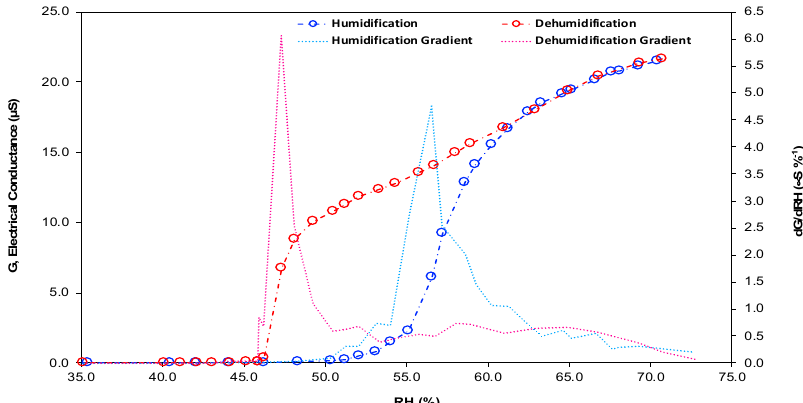
Figure 3. Electrical conductance (G) measurements during a humidity cycle (RH) in the Aerosol Exposure Chamber (AEC) of MI-TS winter sample collected in March 2009 (24 h sampling). Circles indicate the measured electrical conductance (blue: during humidification, red: during dehumidification). Dotted lines indicate the conductivity curves gradient, dG / dRH. Deliquescence relative humidity (DRH) and crystallization relative humidity (CRH) values are individuated in correspondence to the maximum gradient point for humidification (blu) and dehumidification (red) curves, respectively. Data for the present figure are extracted from Ferrero et al. [18]. Table 1. Highest, lowest and average measured values for ∆ G deliquescence , ∆ G crystallization and maximum measured conductance ( µ S) for the subset of samples (42) with measured DRH and CRH. ∆ G ∆ G G max deliquescence crystallization ( µ S) ( µ S) ( µ S) Minimum 0.35 0.04 0.57 Maximum 54.04 10.01 127.77 Average 8.56 35.54 1.35